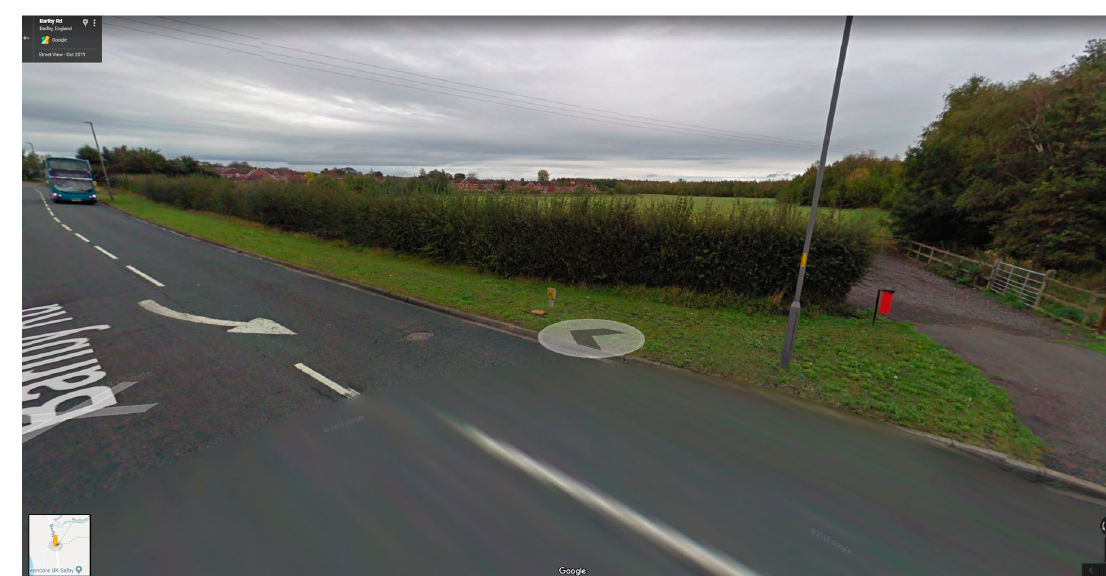
Figure 3. Barlby greenfield site, Barlby Road, Yorkshire.